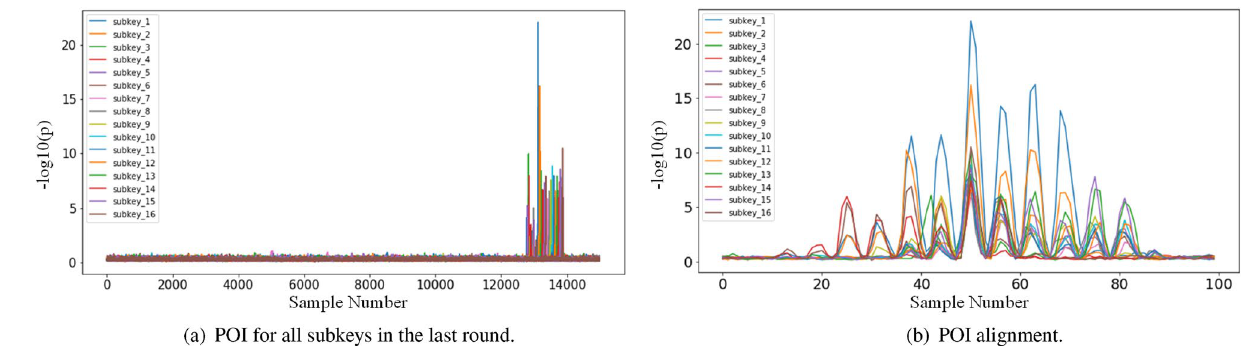
Figure 9. The result of all subkey POI and the result of POI alignment (AES_GPU).